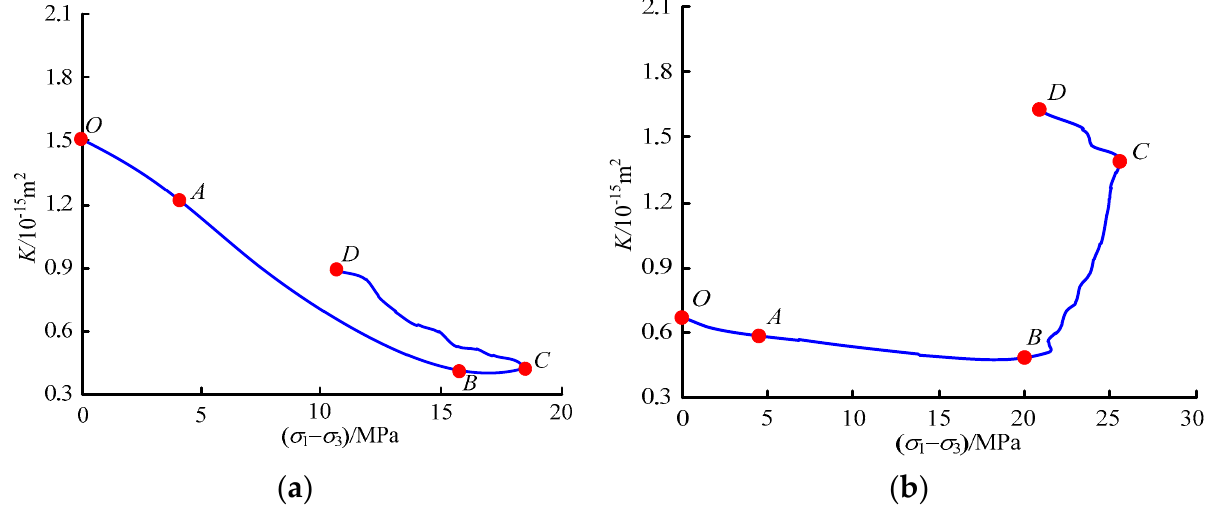
Figure 7. Axial pressure-permeability curves of briquette and raw coal. ( a ) Briquette; ( b ) raw coal.